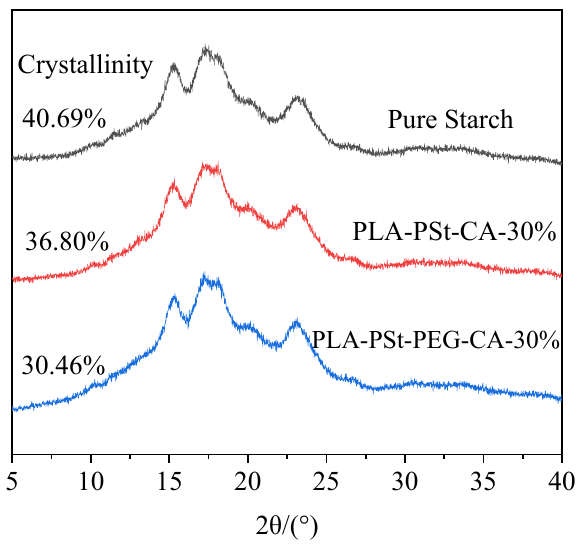
Figure 5. XRD patterns of pure starch and pretreated PLA/PSt/CA and PLA/PSt/PEG/CA powder samples.